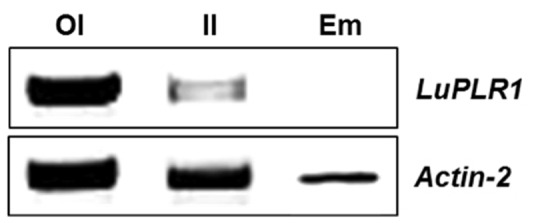
LuPLR1 gene expression in the outer integument (OI), inner integument (II) and embryo (Em) of S3 (ca 22 days after flowering) wide type developing seeds analyzed by RT-PCR. Total RNA isolated from manually separated tissues was subjected to RT-PCR semi-quantitative analysis using an ACTIN gene as internal control. 27-cycle PCR products (10 μm) were loaded on 1 % (w/v) agarose gel. OI, outer integument (Part B); II, inner integument (Part A); Em, embryo.